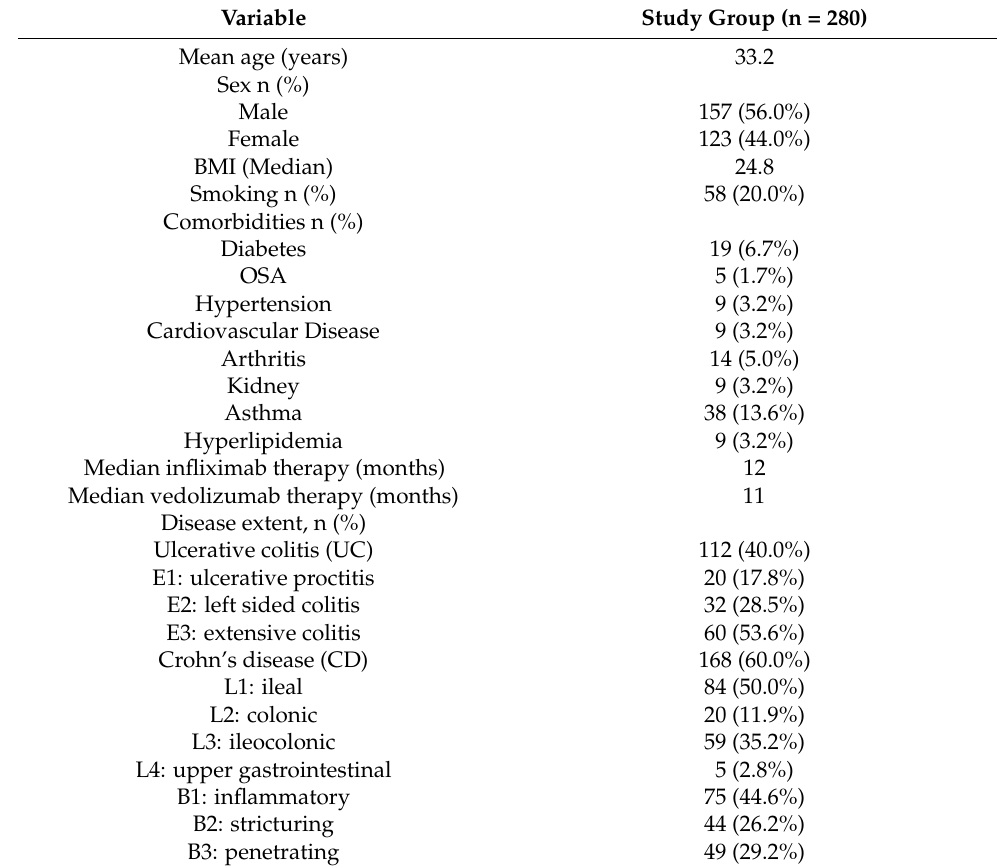
Table 1. Demographics of Patients with IBD.